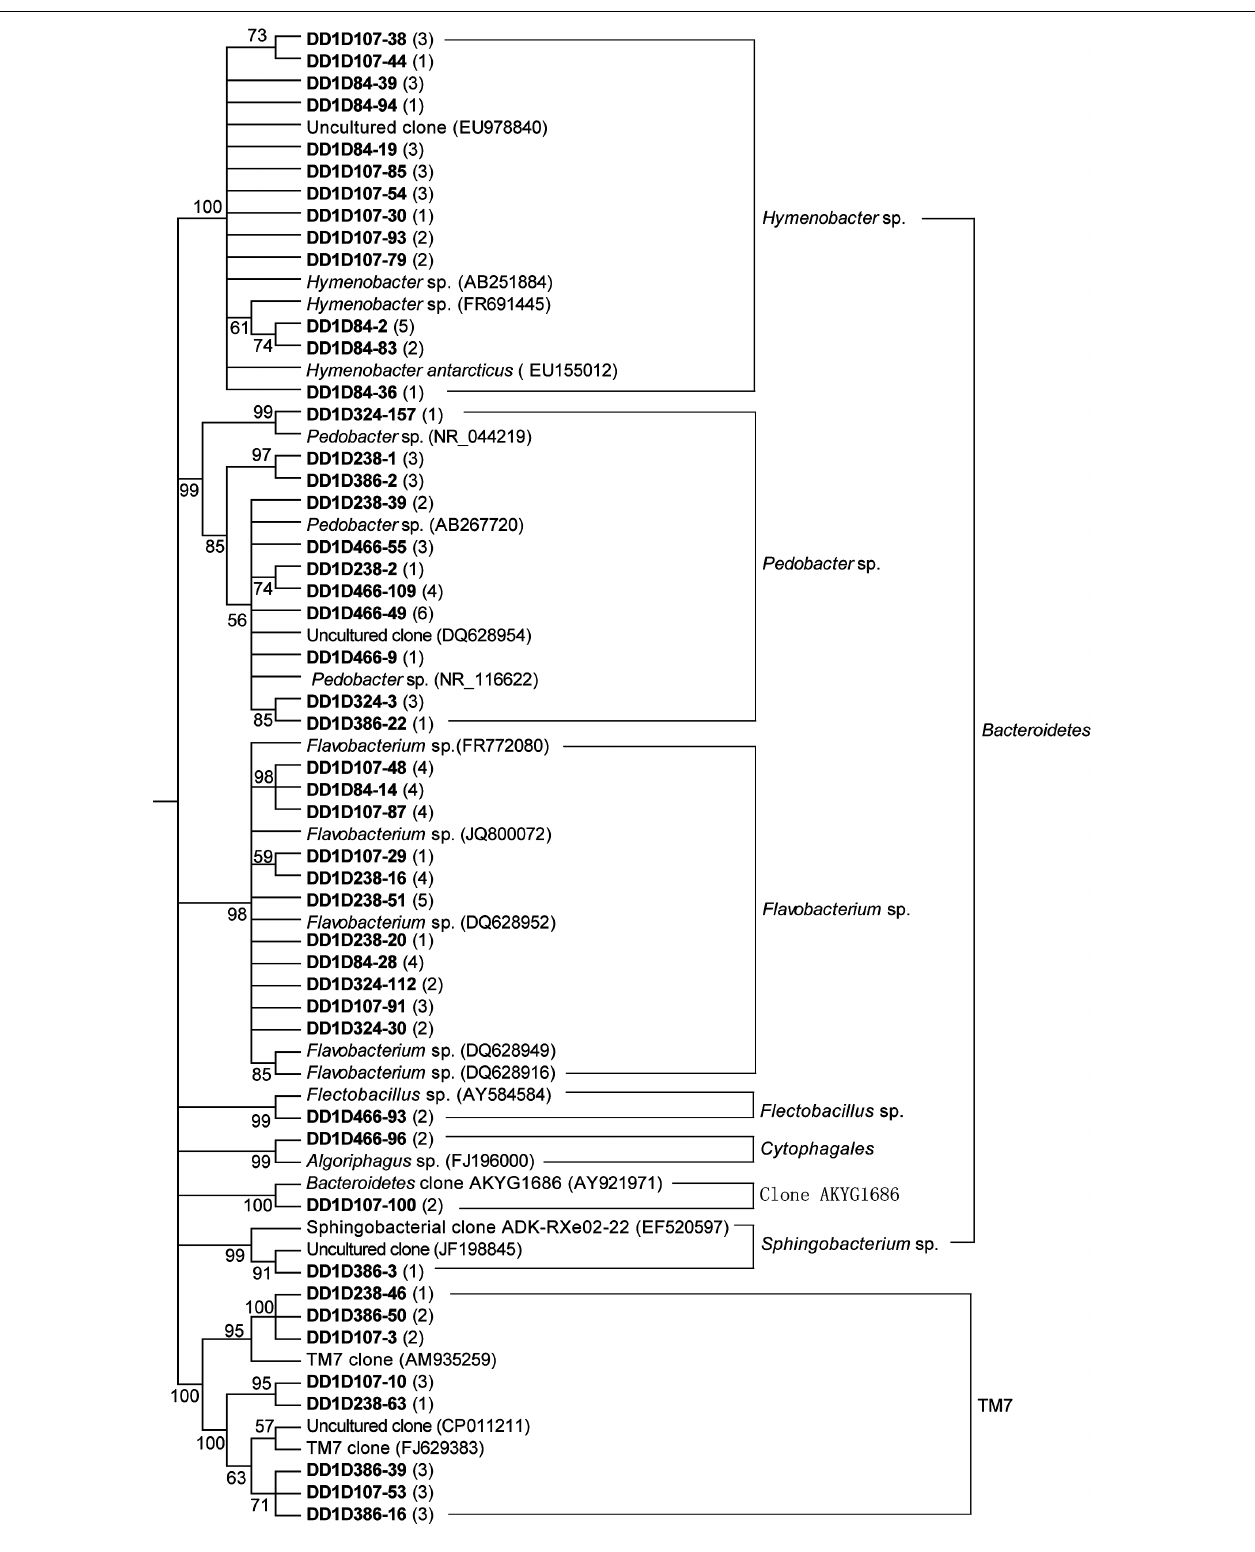
FIGURE 7 | Phylogenetic analysis of the 16S rRNA genes for the Bacteroidetes and TM7 candidate clones from the Dunde ice core and the closest relatives. The tree was constructed by following the protocol as described in Figure 5 .